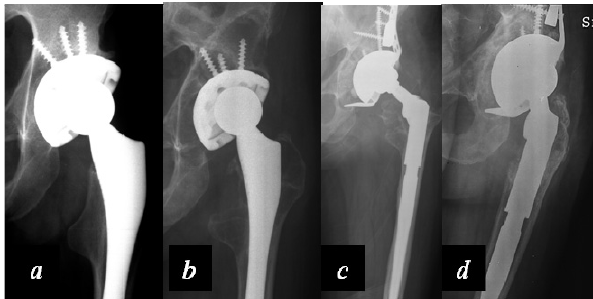
Figure 5. ( a ) Primary total hip arthroplasty (THA) of a 47 ‐ year ‐ old severe haemophilia A patient; ( b ) Aseptic failure of the implant with loosening; ( c ) Revision with modular acetabular and femoral prostheses and acetabular reconstruction by biological composite (heterologous bone chips enriched with a concentration of autologous mesenchymal cells harvested from the iliac crest) and a trabecular metal wedge fixed by screws; ( d ) Four years after revision surgery, optimal integration of the components.